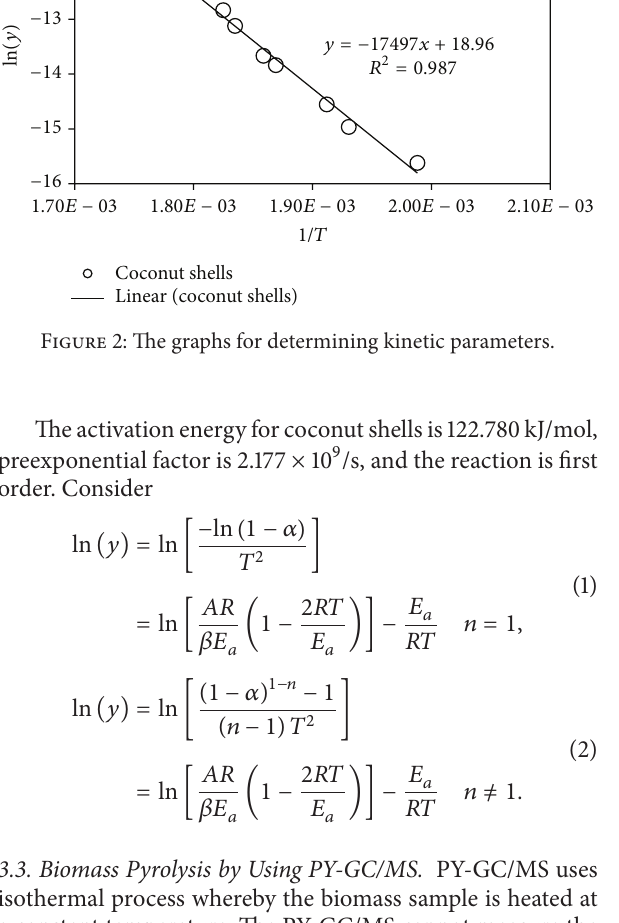
Table 2: Biomass composition. Biomass Cellulose Hemicellulose Lignin Reference Coconut shells 19.8 50.1 30.1